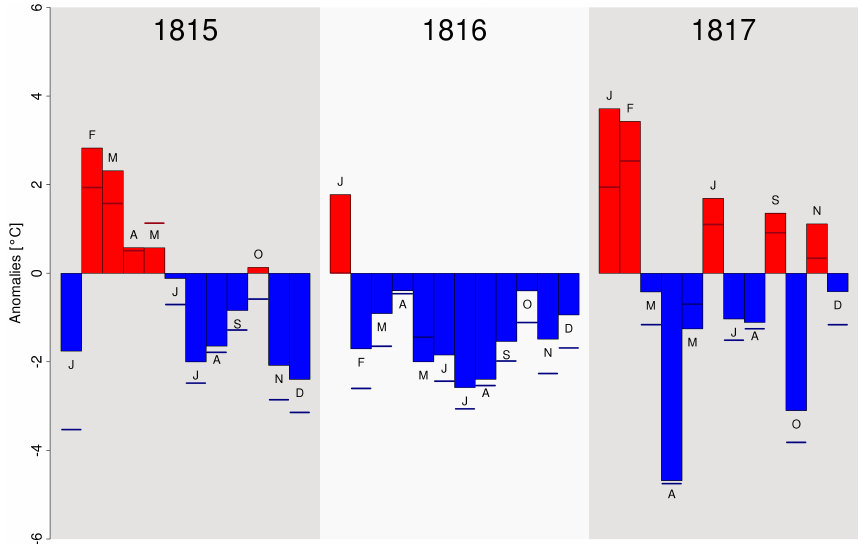
Figure 4. Monthly temperature anomalies in Central Europe (Southern Germany, Bohemia, Austria, and Switzerland) in the period 1815– 1817 with respect to 1801–1830 (bars) and 1961–1990 (segments). Data are from Dobrovolný et al. (2010).